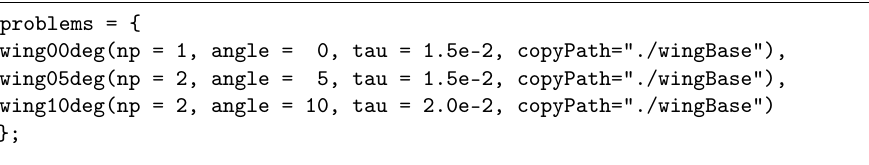
Figure 15. The example of the copyPath parameter usage.